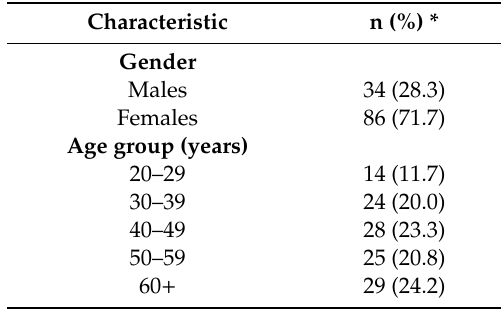
Table 2. Characteristics of sensory participants.